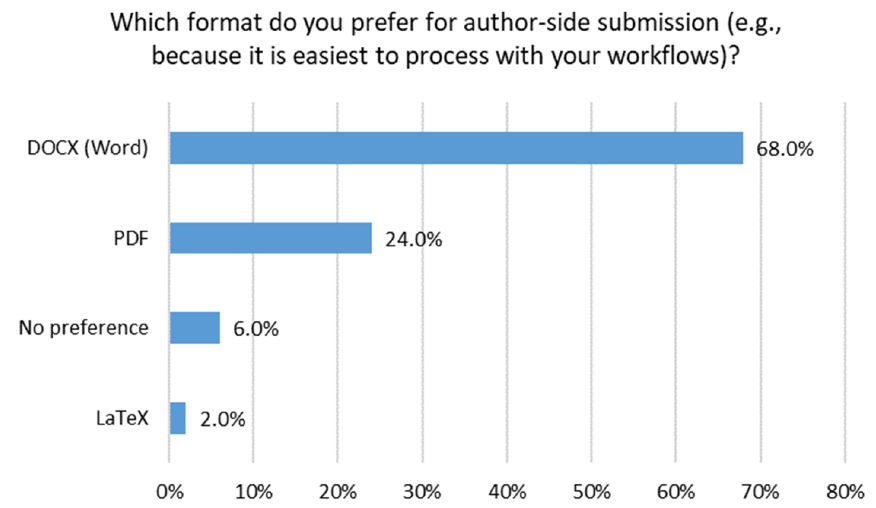
Figure 1. Manuscript acceptance preferences of the surveyed publishers (own representation, trans- lated from [2]).